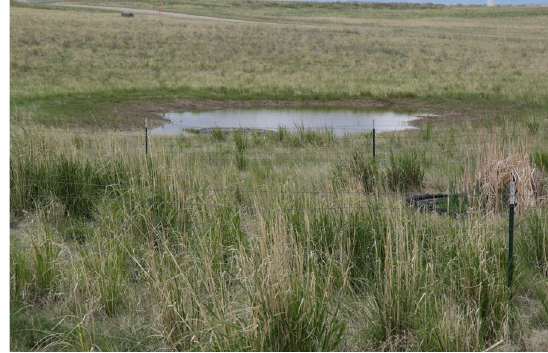
Fig. 16 A reclaimed site with hydrological restoration (June